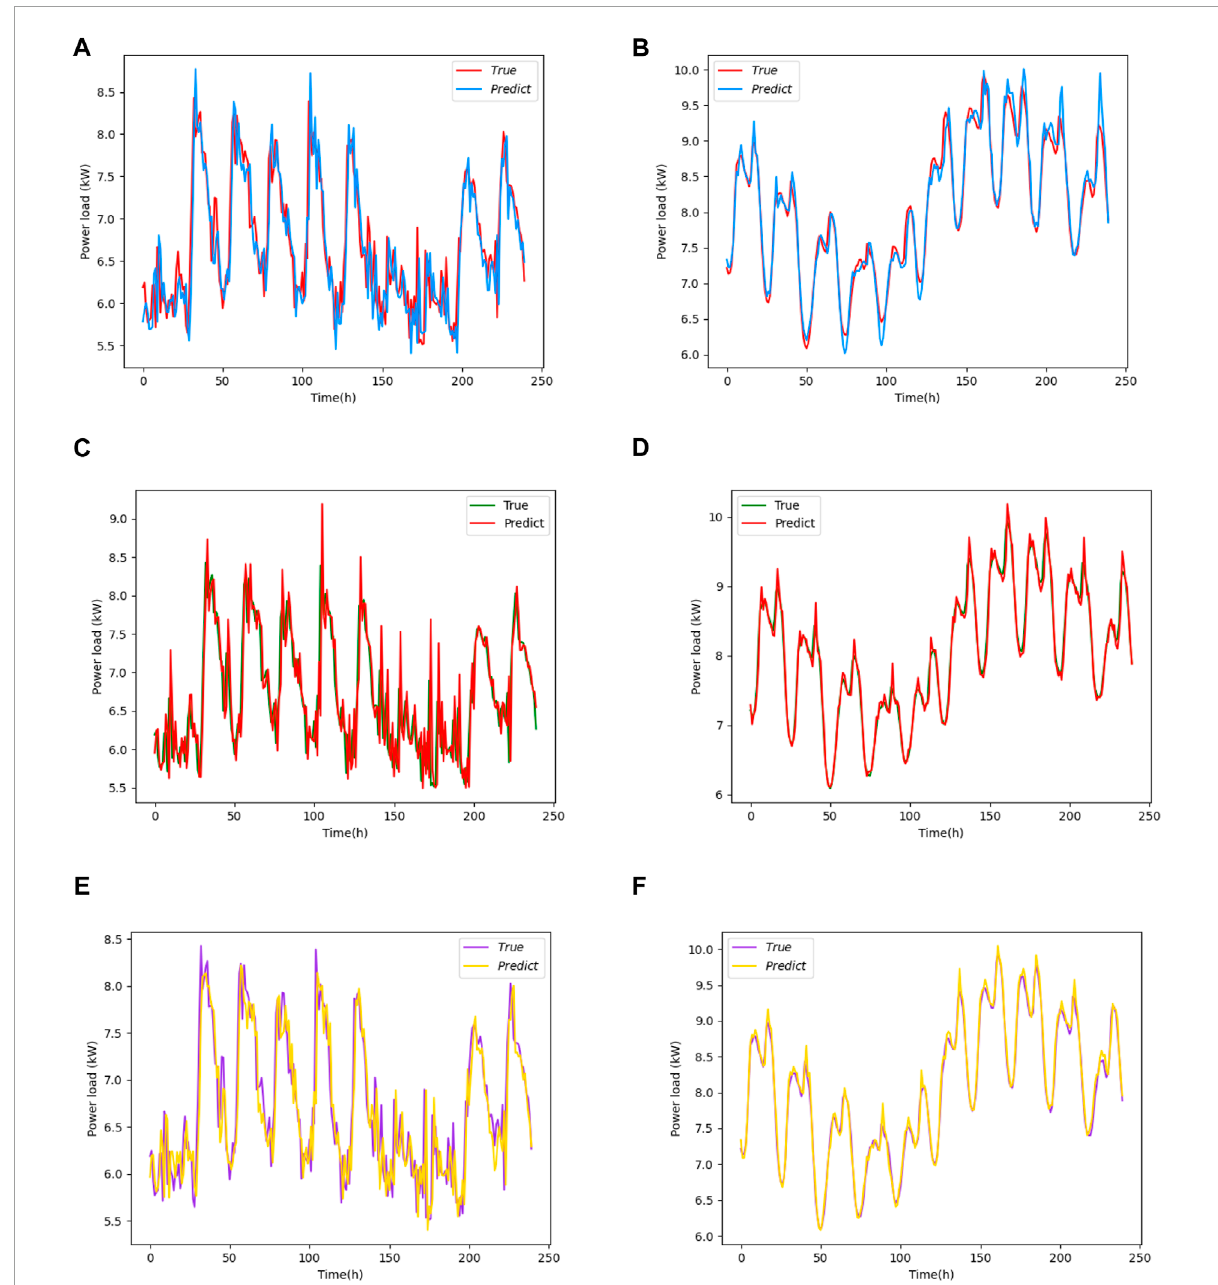
FIGURE 9 True and predicted load with different models with dataset 1 and dataset 2. (A) Results of the DBN model with dataset 1. (B) Results of the DBN model with dataset 1. (C) Results of the SVM model with dataset 1. (D) Result of the SVM model with dataset 2. (E) Results of the LSTM-Seq2Seq model with dataset 1. (F) Results of the LSTM-Seq2Seq with dataset